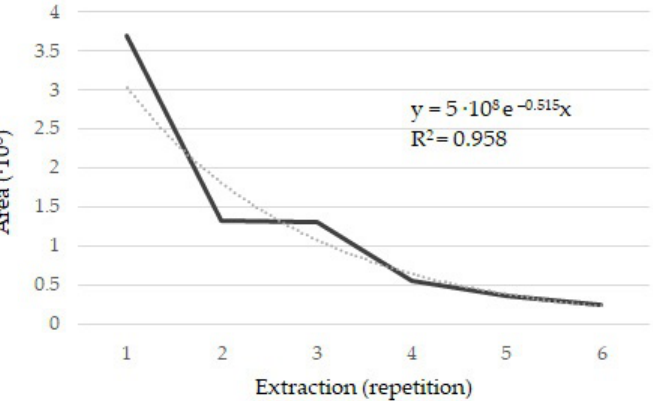
Figure 1. Progression of safranal peak area in saffron samples (33.5 mg powdered saffron) subjected to 30 ◦ C for 40 min and purified using stir bar sorptive extraction in six consecutive extractions.